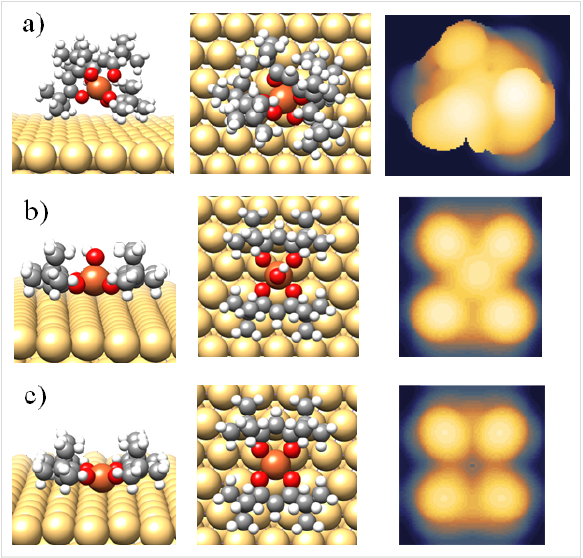
Figure 7: Optimized geometries of the three theoretical models Fe(dpm) 3 @Au(111) (a), FeOH(dpm) 2 @Au(111) (b), and Fe(dpm) 2 @Au(111) (c) presented as side (left column) and top views (middle column). Simulated STM images at experimental bias are also reported in the right column. (a) Bias = − 1.5 eV (filled states); size = 17.31 × 14.99 Å 2 . (b), (c) Bias = 2 eV (empty states); size = 14.44 × 14.99 Å 2